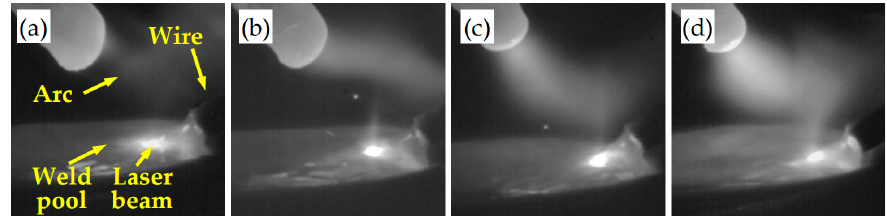
Figure 6. Laser–TIG morphology in a stable state with different currents: ( a ) I = 30 A; ( b ) I = 40 A; ( c ) I = 50 A; ( d ) I = 60 A.